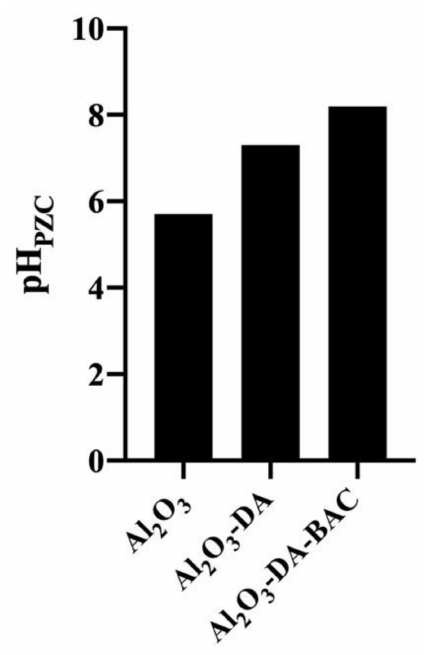
Figure 4. Point of zero charge of the functionalized and Al 2 O 3